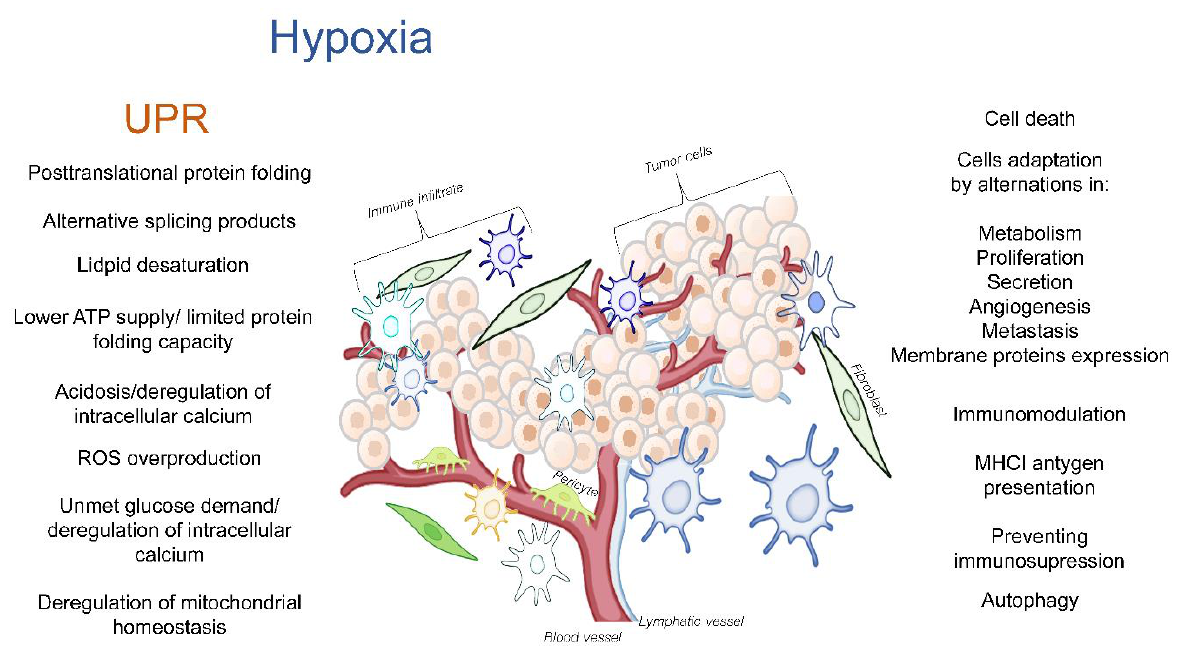
Figure 1. The hypoxia-related deregulation of ER homeostasis in TME cells that can result in activation of the UPR and UPRmt and subsequently modulate TME.